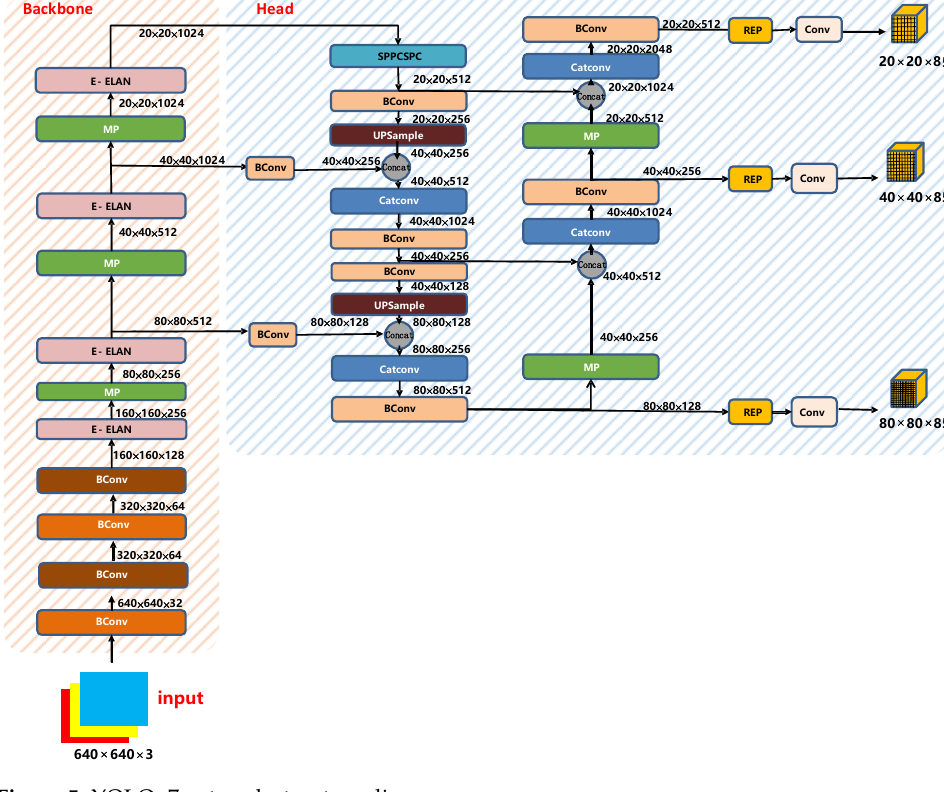
Figure 5. YOLOv7 network structure diagram.